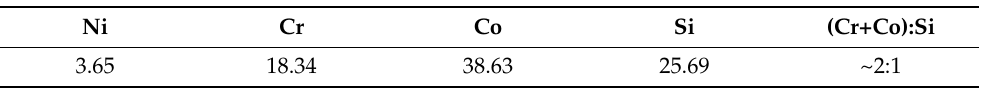
Table 2. The phase composition of the new type of Cu-1.1–Ni-0.7–Co-0.45–Si-0.3Cr alloy subjected to compression at 600 °C and 0.01 s − 1 .